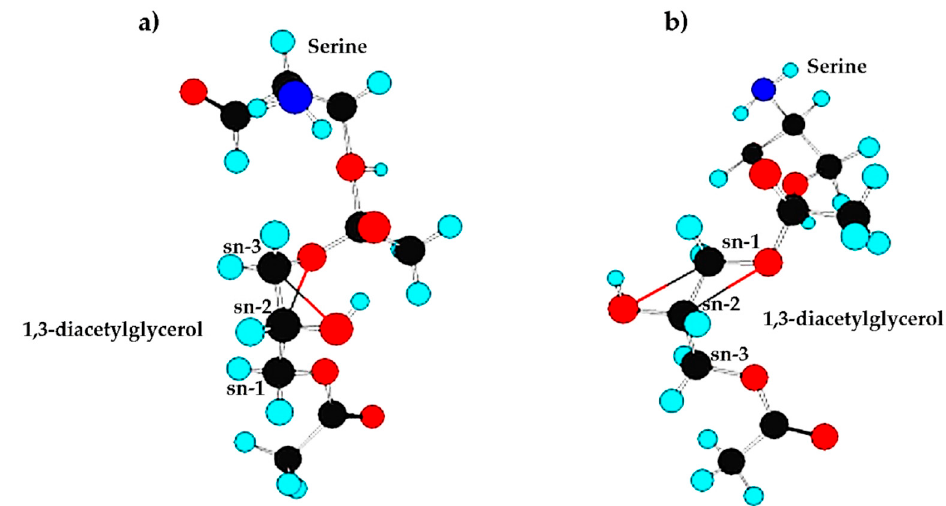
Figure 4. Three-dimensional representation of the coordination of 1,3-diacetin with the Serine residue of the catalytic triad. ( a ) Interaction through acyl at the sn-3 position and ( b ) interaction through acyl at the sn-1 position.